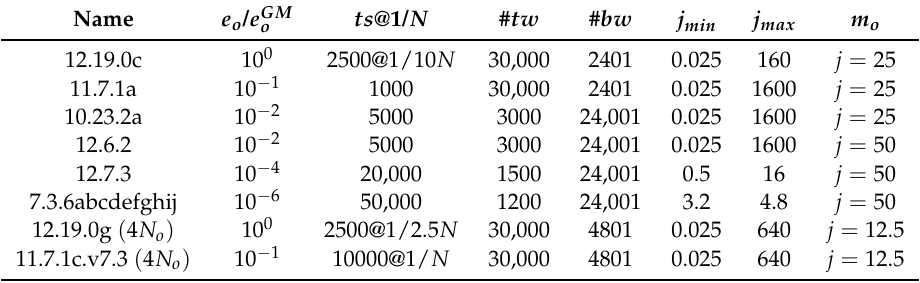
Table A2. Run summary for estimating the spectral moments that appear in Figure 4. We create an ensemble of test wave time series by creating multiple realizations (# tw ) of the randomly phased inertial field having # bw